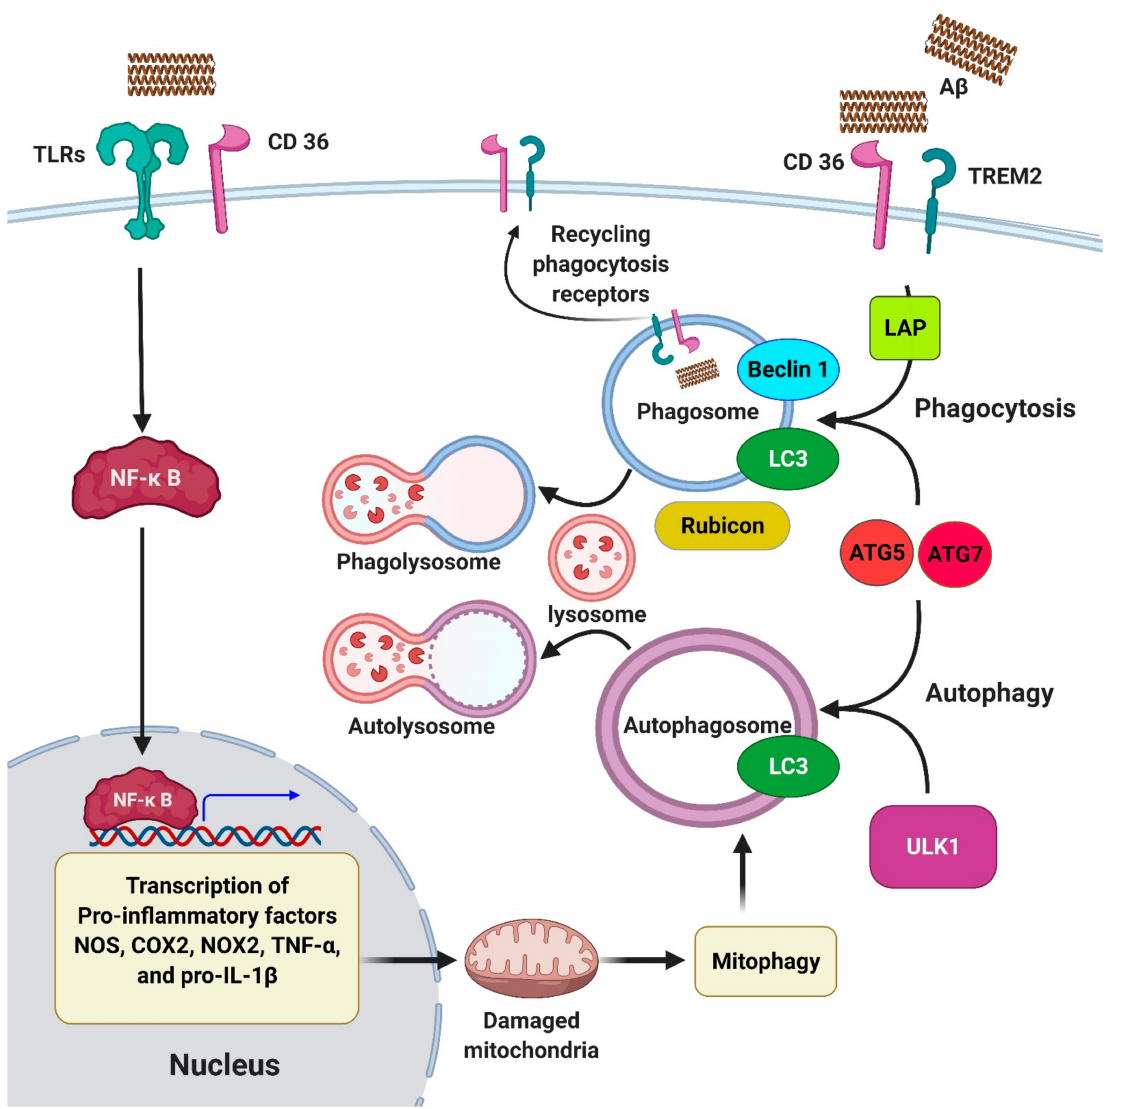
Figure 5. Cooperation of autophagy with phagocytosis in microglial activation. Autophagy and phagocytosis are tightly intertwined, making them promising therapeutic targets in Alzheimer’s diseases. Autophagy could be activated by activation of ULK 1. Interaction of A β with TREM2 and CD36 at the surface of microglia initiates phagocytosis, which is facilitated by autophagy mediators. LC3 recruitment to the single-membrane phagosomes is mediated by the activity of ATG 5 and ATG 7. Thereafter, Beclin1 and LC3 proteins translocate to the phagosomes, enhancing the fusion of phagosome into the lysosomal system. The interaction of autophagy and phagocytosis, through LC3-associated phagocytosis (LAP), enhances the efficiency of microglial phagocytosis in the elimination of extracellular cargos including A β aggregates. Rubicon’s activity is critical in the production of PtdIns(3)P at the phagosome, triggering the recruitment of the ATG5–12 and LC3-PE conjugation systems. On the other hand, toll-like receptors (TLRs) are involved in the induction of microglial autophagy. TLRs initiate signaling pathways, such as NF- κ B. This pathway triggers the transcription of pro-inflammatory factors, such as NOS, COX2, NOX2, TNF- α , and pro-IL-1 β , which are damaging to mitochondria, and consequently, induce the autophagic